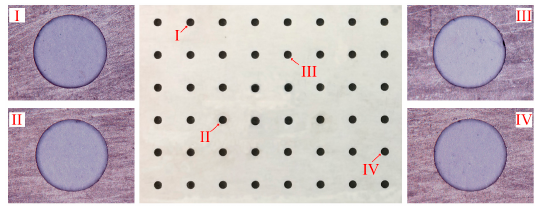
Figure 11. Hole array structure fabricated by TMECM.